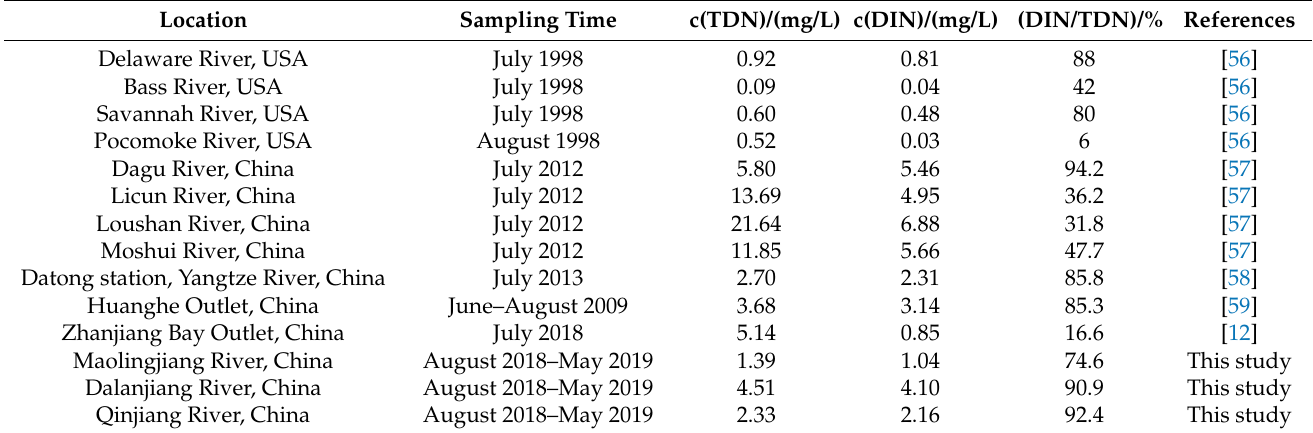
Table 2. Comparison of TDN average concentration and composition in different rivers.